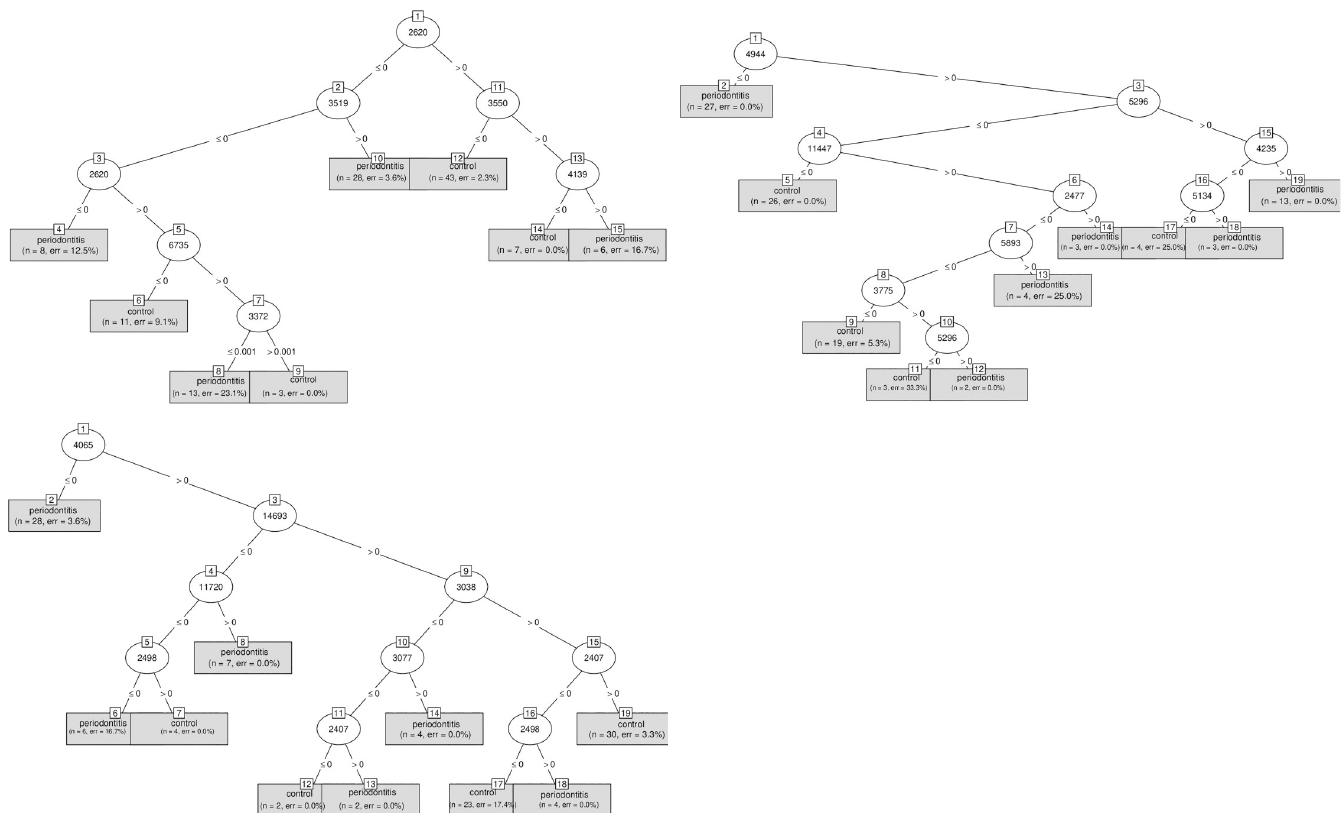
Fig 2. Diagnostic decision trees based on differentially expressed peaks between periodontitis and control groups (a. saliva, b. GCF, c. dental plaque).